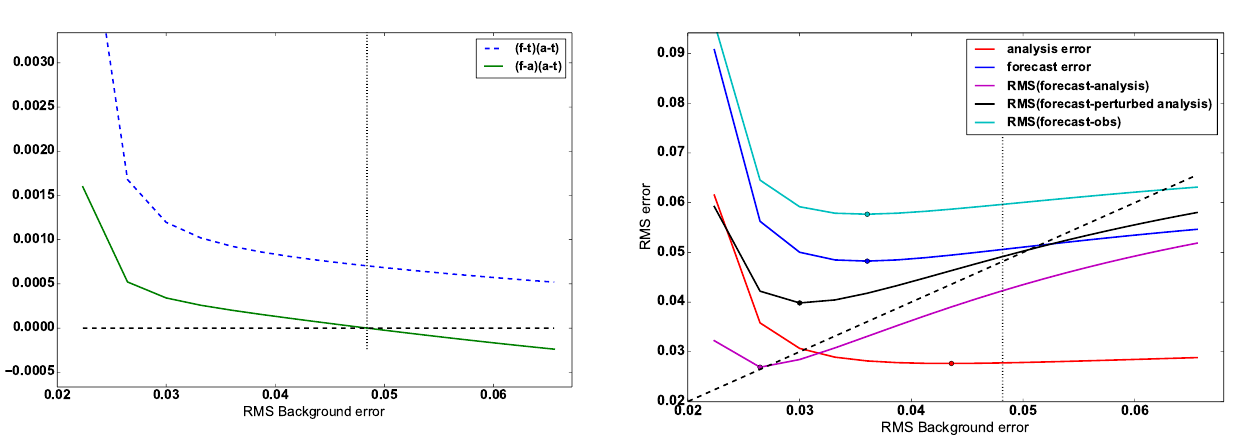
Figure 2. Important cross-terms calculated from a long analysis cy- cle using the logistic model, as a function of the background er- ror standard deviation used in calculating the analysis. These are < ( x f − x t )( x a − x t ) > (blue dashed) and < ( x f − x a )( x a − x t ) > (green solid).